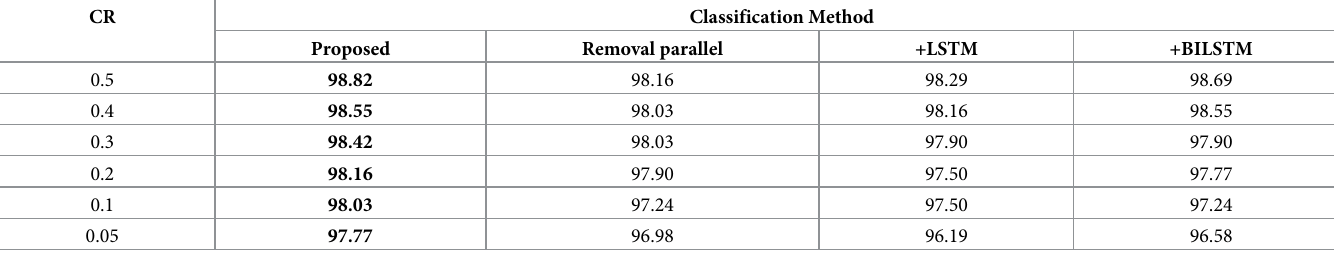
Table 11. Accuracy of different classification methods in the MIT-BIH ECG signal database test set at different compression ratios.